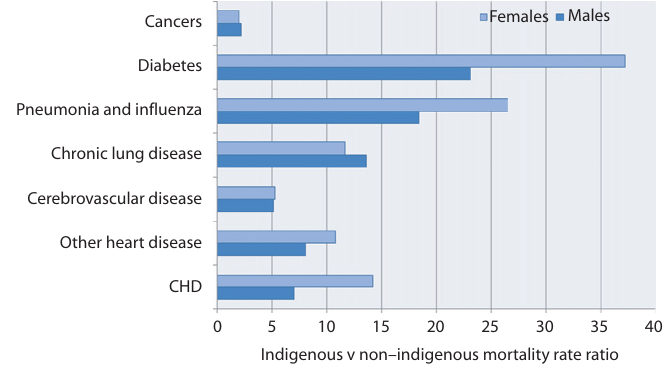
Figure 4. Age specific mortality differentials between indigenous and non-indigenous Australians, 35–54 years, by cause, 2001–2005. Source: AIHW National Mortality Database. last four decades, CVD still accounts for over 35 per cent of all deaths [12] and conservatively costs Australian society $14 billion in direct and indirect health costs